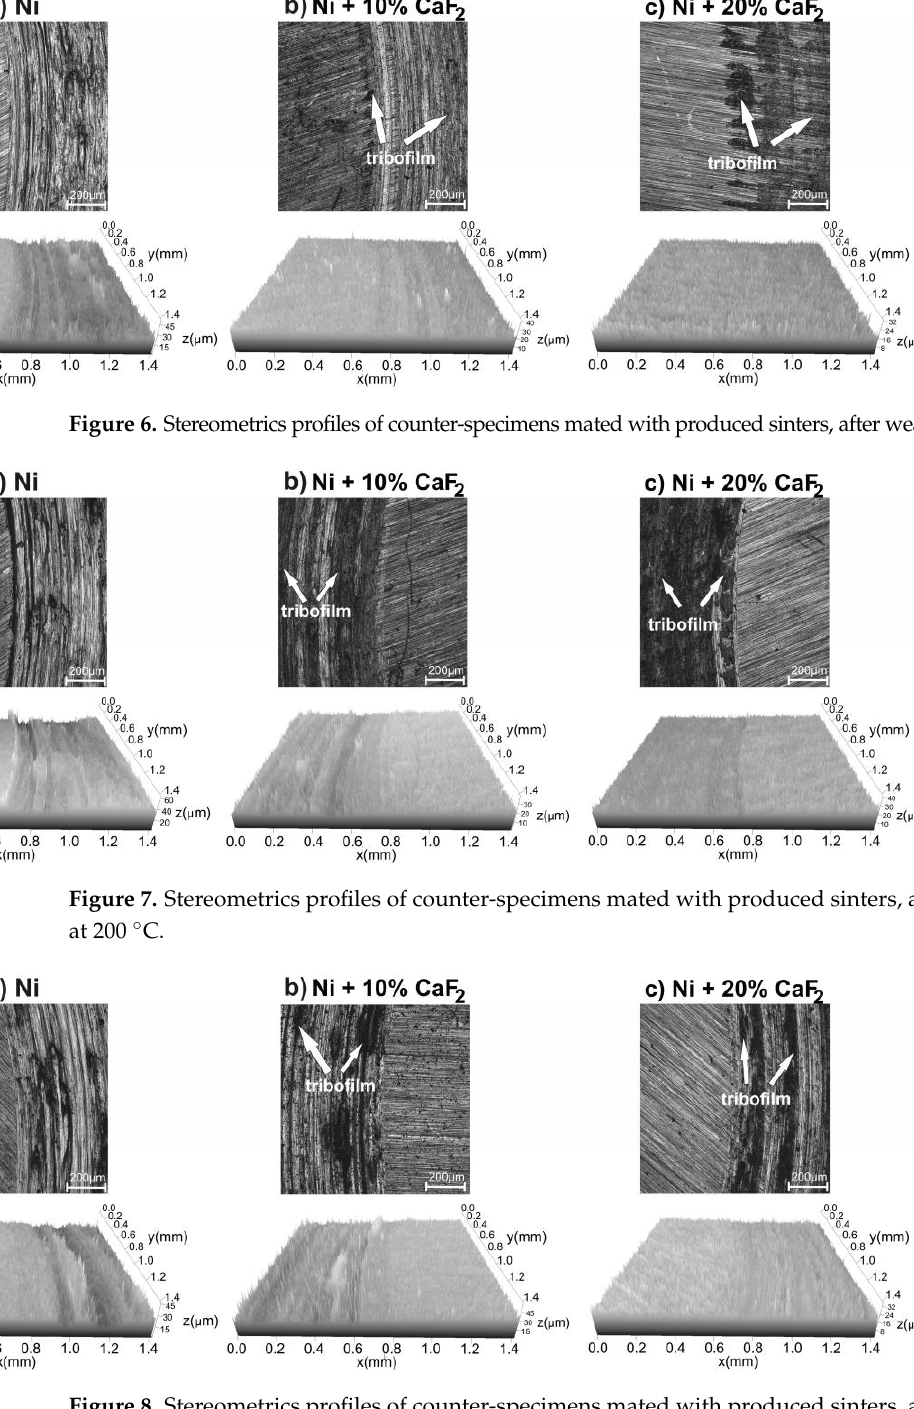
Figure 9. Stereometrics profiles of counter-specimens mated with produced sinters, after wear test at 600 °C. The results of the micro-Raman spectroscopy are shown in Figures 10 – 14. The Raman spectra for the CaF 2 powder are presented in Figure 10. The spectrum for the CaF 2 was characterized by the appearance of a peak at 321 cm − 1 . Therefore, the micro-Raman maps (Figures 11 – 14) showed intensity changes at wavenumber equal to 321 cm − 1 . In the case of the wear test conducted at room temperature, maps for the sample containing 10% CaF 2 , showed more areas with higher intensity than the maps characteristic for the sample with 20% CaF 2 . The situation changed at 200 °C and 400 °C. In these cases, higher intensity areas appeared on the Ni-20% CaF 2 sample, which meant that the tribofilm was charac- terized by a higher thickness. Additionally, the values of the µ a were lower for the nickel modified by 20% CaF 2 . The maps obtained for the samples worn at 600 °C were similar to each other. The sizes of the tribofilm areas and the intensity were comparable. Because of that, the values of the µ a were almost equal: 0.47 vs. 0.46. The results of the Raman spec- troscopy showed, that the tribofilm was made of CaF 2 . This research method proved that the CaF 2 has high chemical and thermal stability, because it occurred on the surface of the sample as the same chemical compound which was used to produce the samples. The Raman spectroscopy is a very useful method, compared to, e.g., EDS method, because it can detect the chemical compounds which are formed on the surface of the sample during wear, whereas the EDS method, which is widely used to analyze the wear of the materials, detects only the elements that appear on the surface of the sample.